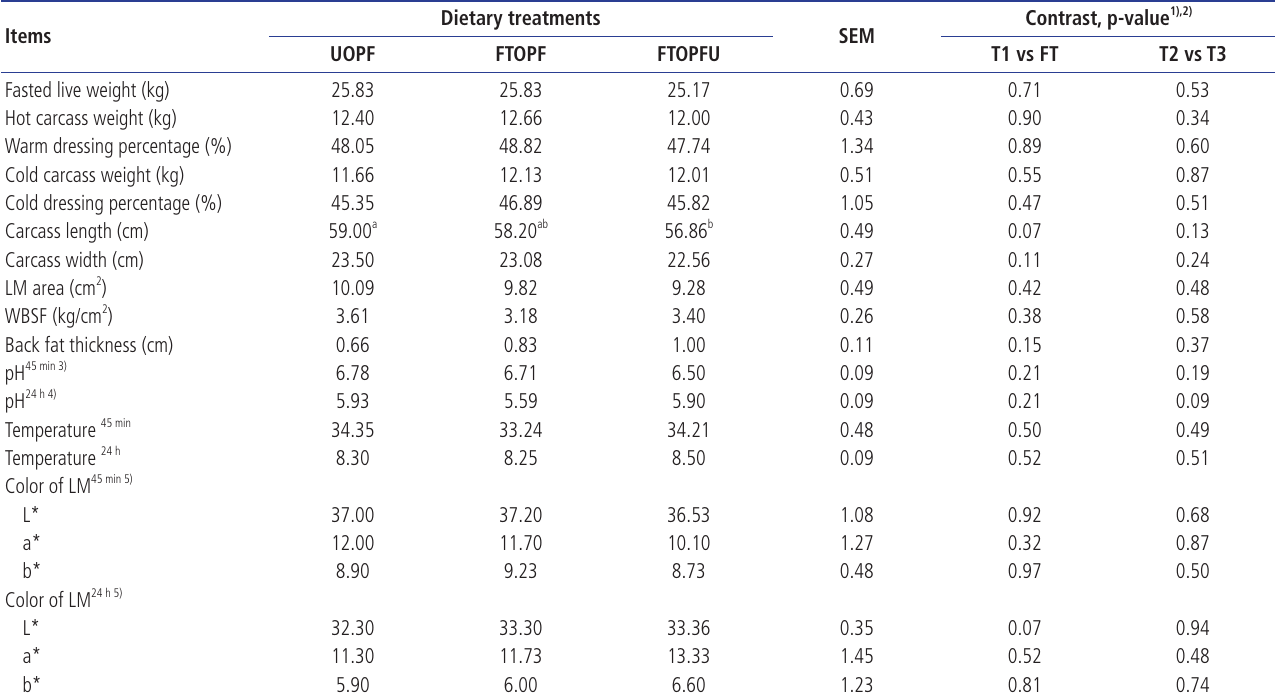
Table 3. Effects of diet on slaughtered carcass characteristics of finishing goats